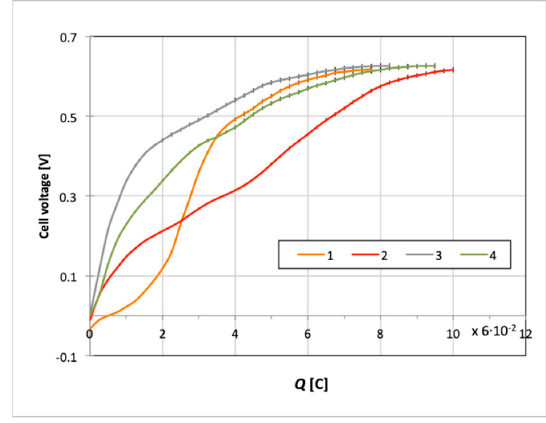
Figure 8. Influence of anodic charge on the catalytic activity of Cu–B alloy containing 9% of B.